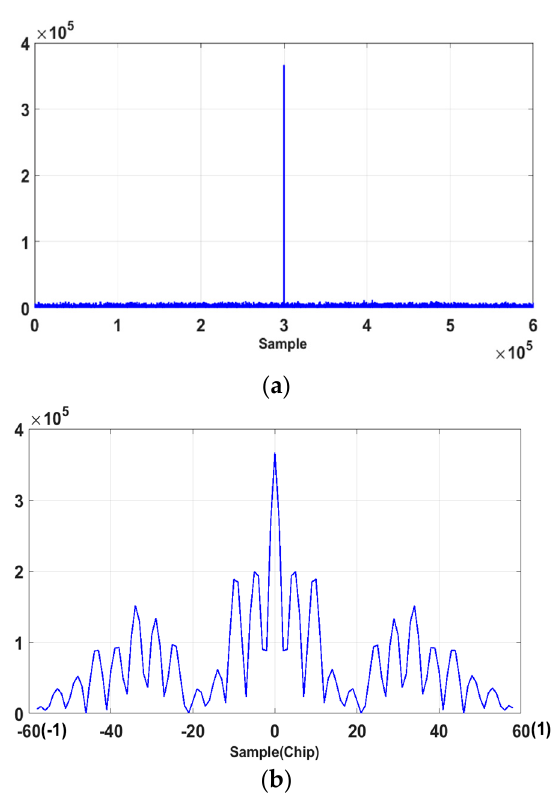
Figure 8. The CCF for the conventional method; ( a ) Correlation plot for 10,230 chips (600,000 samples); ( b ) Correlation plot for ± 1 chip (59 samples) around the correlation peak.